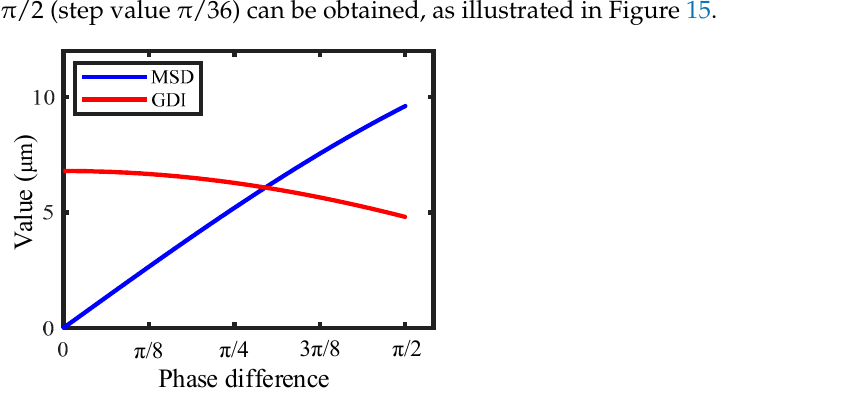
Figure 15. The maximum single-step displacement (MSD) and the gap adjustment interval (GDI) changing with the phase difference in the range of 0 to π /2 (step value π /36).